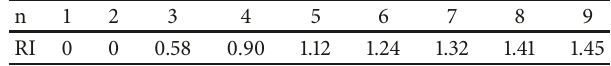
Table 9: The reference values of random consistency